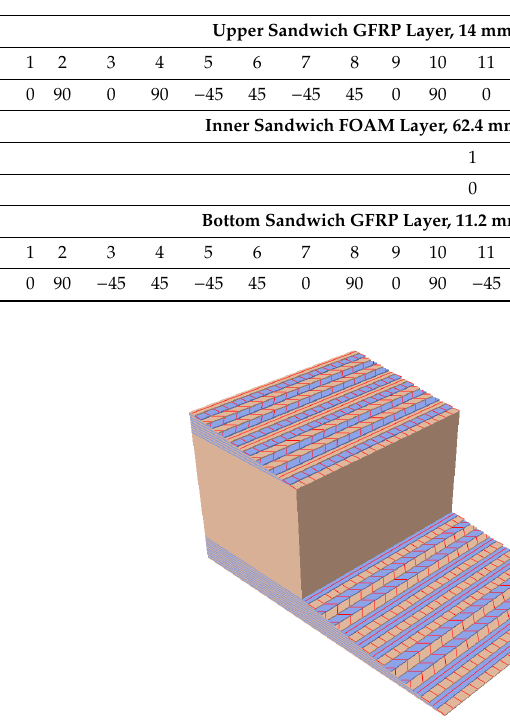
Table 5. The ply table in the composite layup.